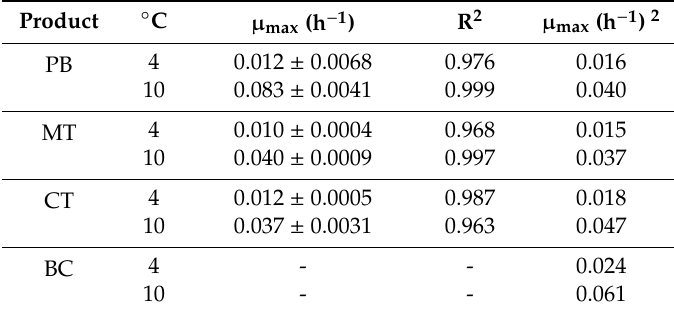
Figure 1. Growth kinetics of L. monocytogenes inoculated in the meals stored at 4 ◦ C and 10 ◦ C in air. The continuous lines represent the forecasts of the dynamic model for all products (except BC), while the symbols are the experimental data. PB: Pasta and broccoli rabe; MT: Meatballs with tomato sauce; CT: Cod with tomato sauce; BC: Mashed broad beans with chicory. Table 2. Maximum specific growth rate ( µ max ) of L. monocytogenes in the products obtained in challenge test